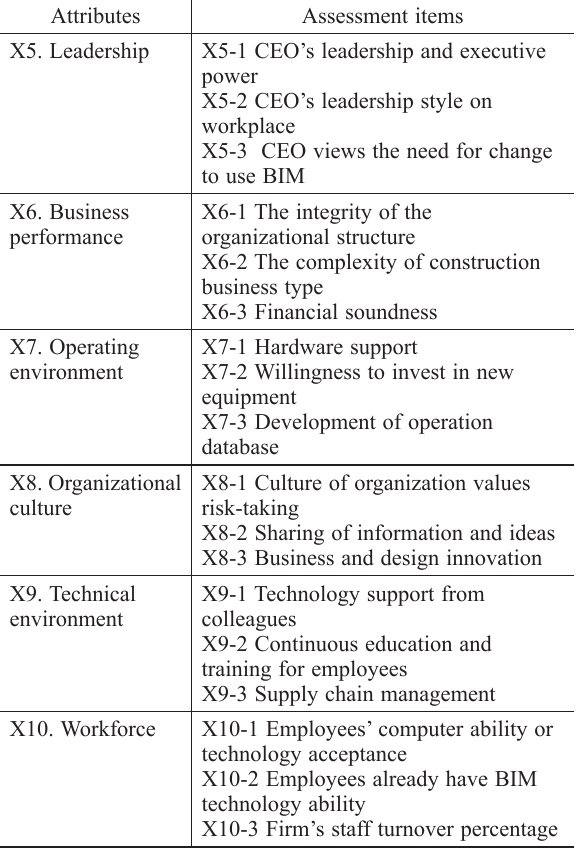
Table 2. BIM organizational readiness assessment